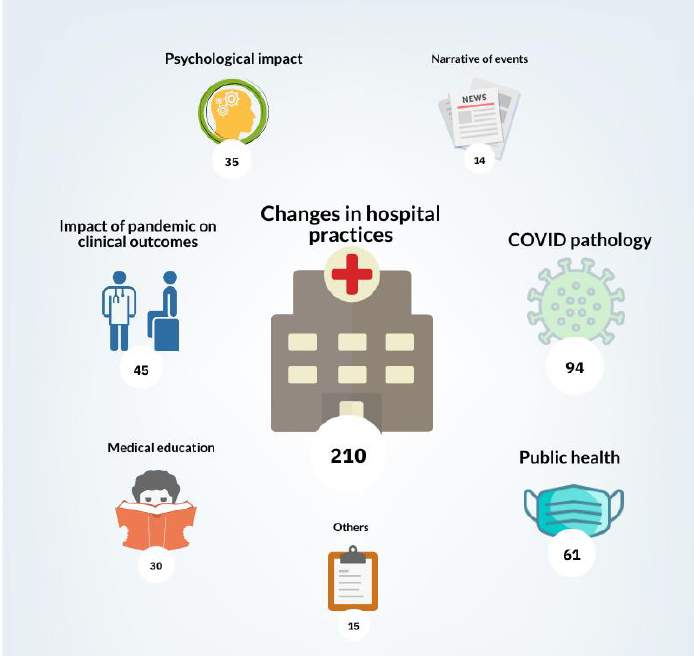
Figure 3. Articles published per month and a timeline of the first year of the COVID-19 pandemic. The 504 articles were further sub-categorised, as presented in Table 1. The sub-categories were created by similarly identifying the recurring sub-themes within each category. Table 1. An overview of the healthcare-related peer-reviewed articles published by the Singapore research community about COVID-19 during the first year of the pandemic.